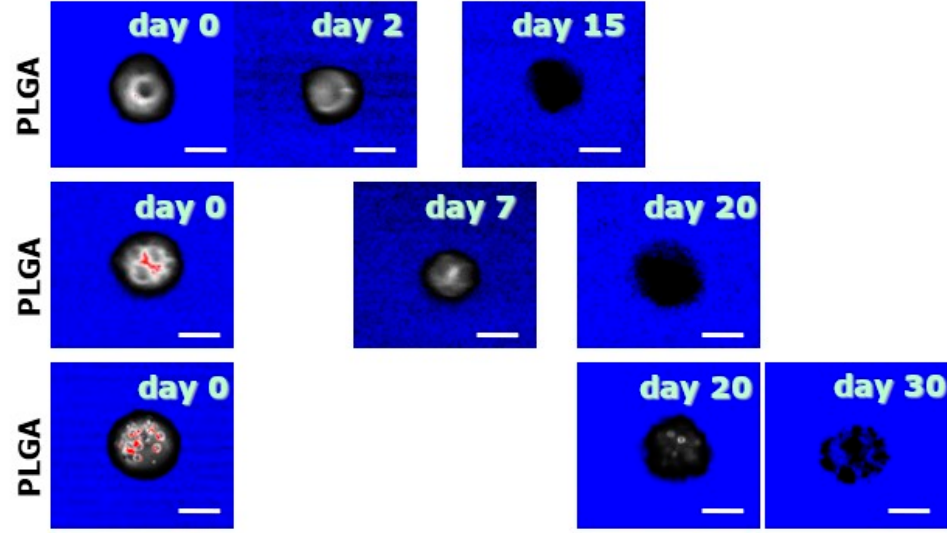
Figure 3. CLSM images of virtual cross-sections of MS. The progressive disappearance of the polymeric matrix is here shown. The bar is 10 m.